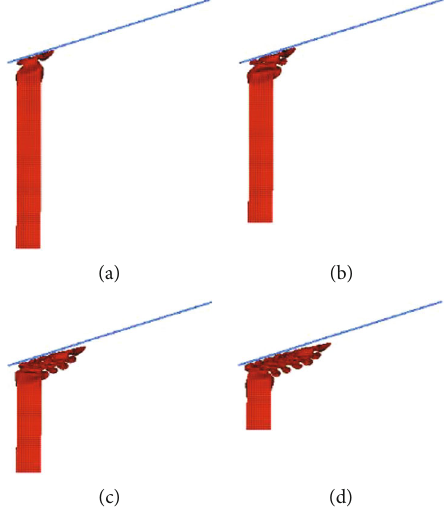
Figure 33: The deformation history of TRB concept tube without transition